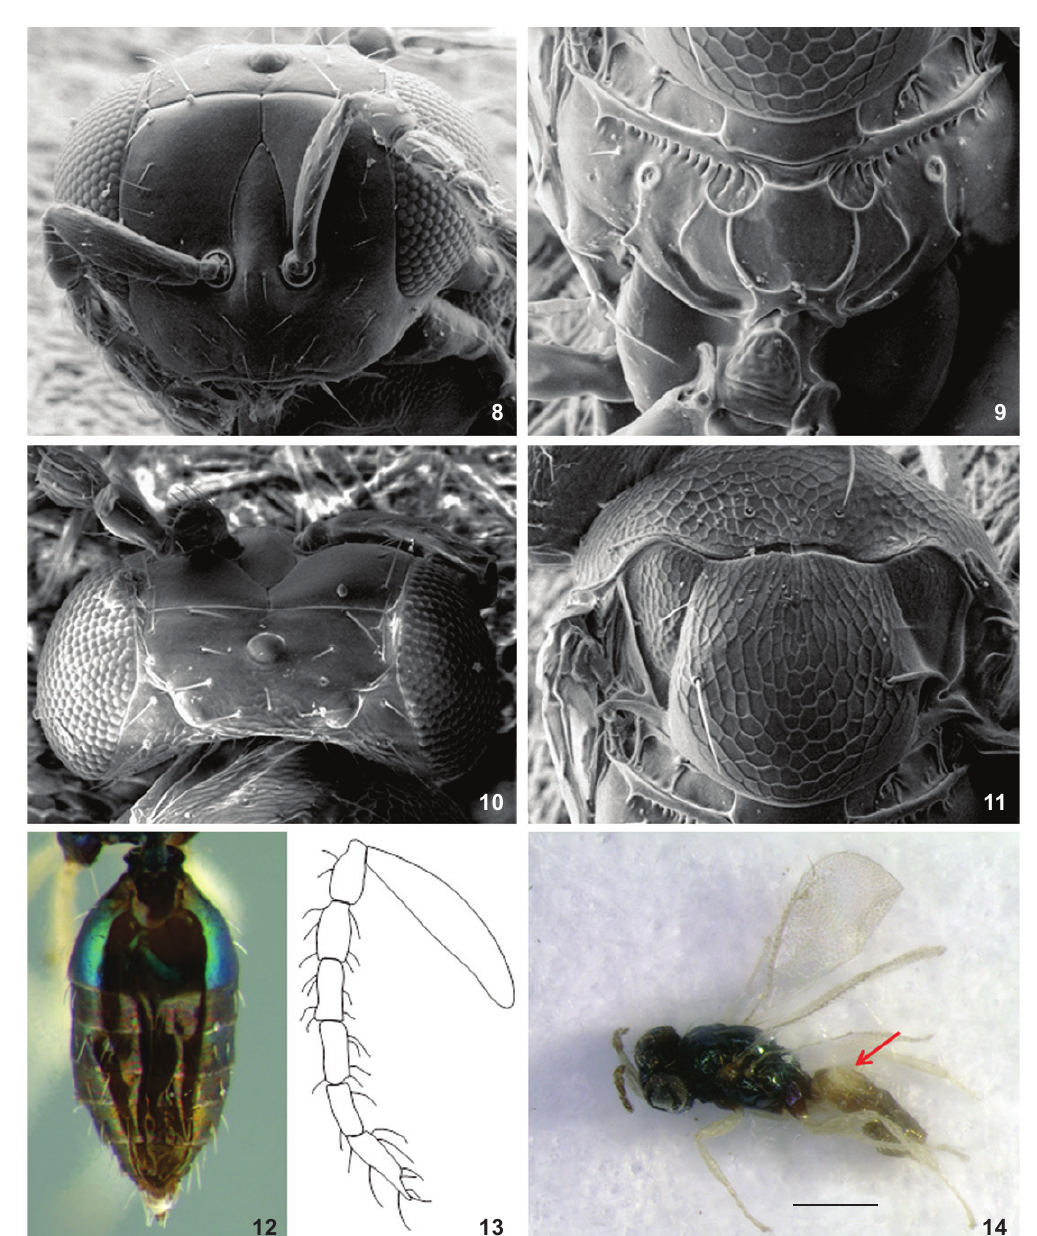
Fig. 8-14. Emersonella frieirocostai sp. nov. , female: (8) frontal view of head; (9) dorsal view of propodeum; (10) dorsal view of head; (11) dorsal view of mesonotum; (12) dorsal view of female gaster, showing color of first gastral tergite; (13) lateral view of antenna; (14) lateral view of male showing gaster with a whitish dorsal spot covering the basal half. Scale bar: 14 = 0.2